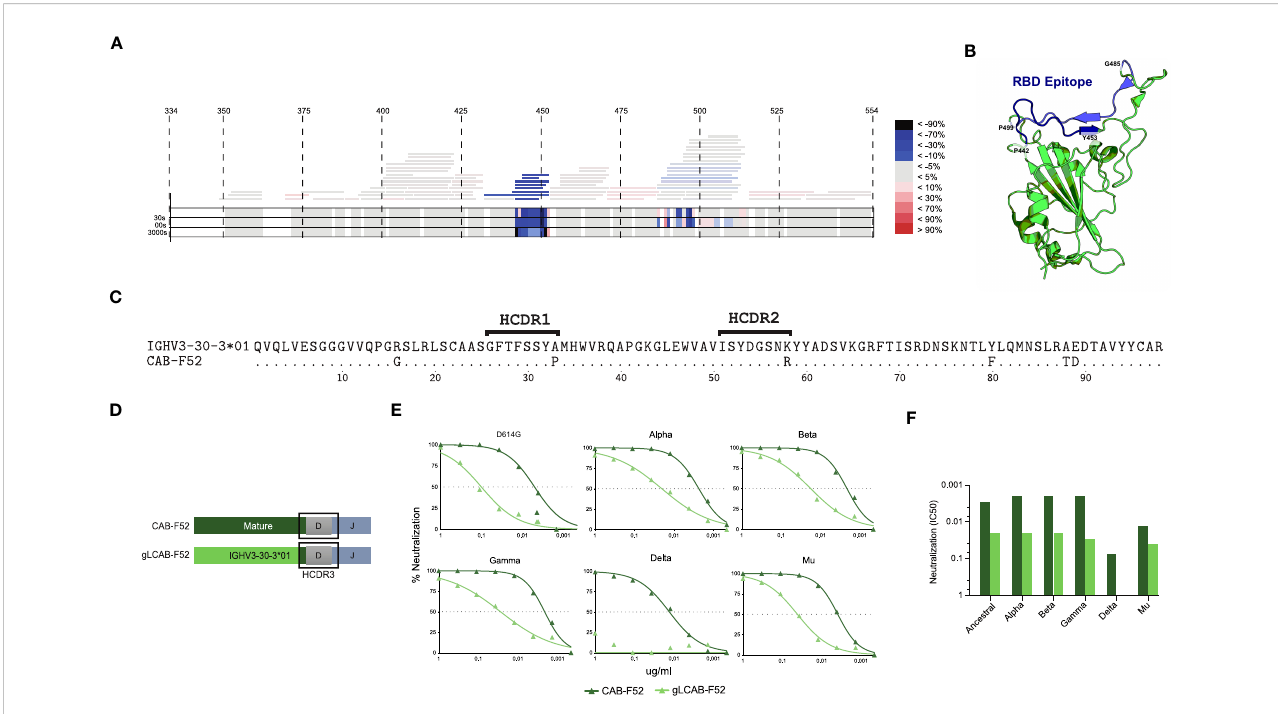
FIGURE 2 CAB-F52 targets RBD and retains neutralization activity upon germline reversion (A) Epitope mapping of CAB-F52 using HDX-MS. (A) A heat map showing the most probable (blue) and least probable (red) interaction sites of CAB-F52 on the RBD (B) A three-dimensional image of the targeted epitope (C) Amino acid sequence alignment of CAB-F52 VH region and germline allele IGHV3-30-3*01 allele. (D) Cartoon showing the gLCAB-F52 HC design (E) Titration curves showing percent neutralization of CAB-F52 and gLCAB-F52 against VoCs. (F) IC50 neutralization values of CAB-F52 and gLCAB-F52 against several